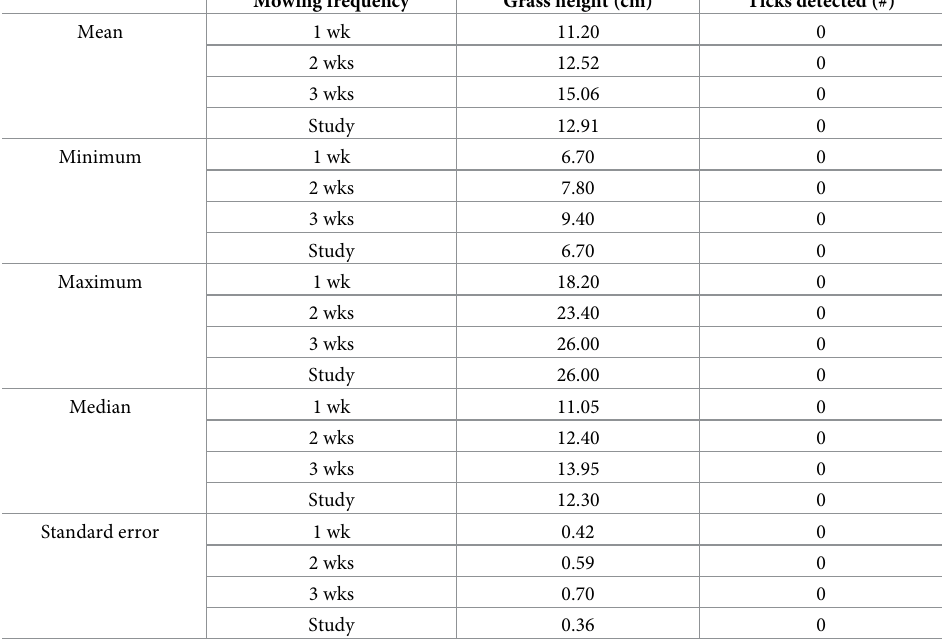
Table 1. Summary statistics for grass height, and number of ticks detected for each lawn mowing frequency (1-week, 2-weeks, 3-weeks) and for the entire study, regardless of treatment. Tick drags and grass height measure- ments were conducted at each site, ten times per season in 2013 and 2014 for a total of 144 tick drags and measurements. Mowing frequency Grass height